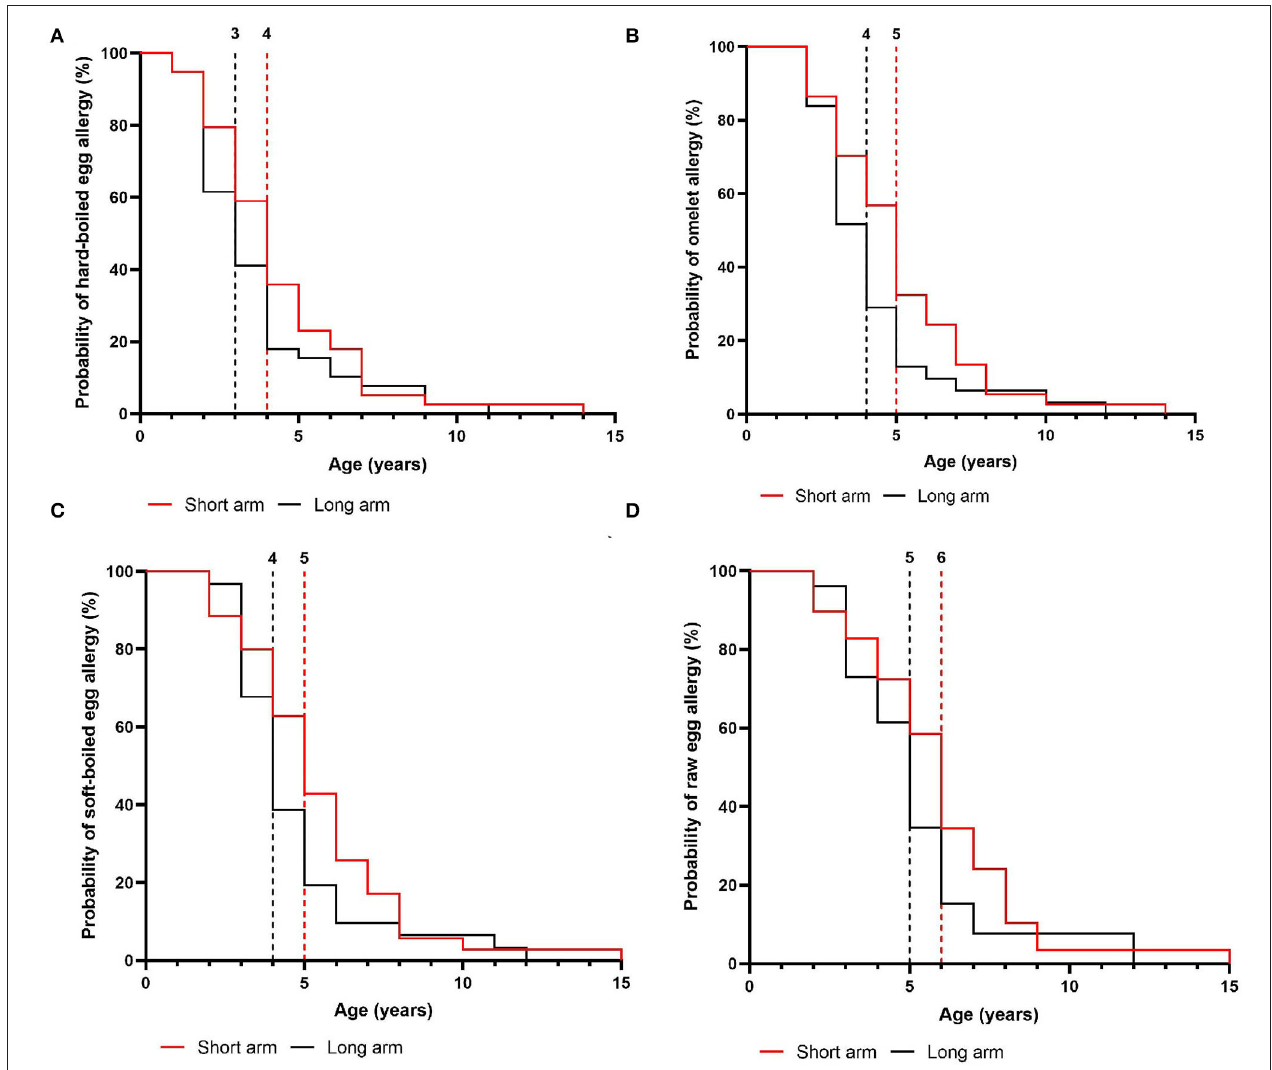
FIGURE 6 | Age of the children at the time of acquiring step-specific tolerance in the intention-to-treat group. (A) hard-boiled egg resolution over time (SA: n = 39, LA: n = 39) (B) omelet resolution over time (SA: n = 37, LA: n = 32) (C) soft-boiled egg resolution over time (SA: n = 35, LA: n = 31) (D) raw egg resolution over time (SA: n = 31, LA: n = 27). SA, short arm protocol; LA, long arm